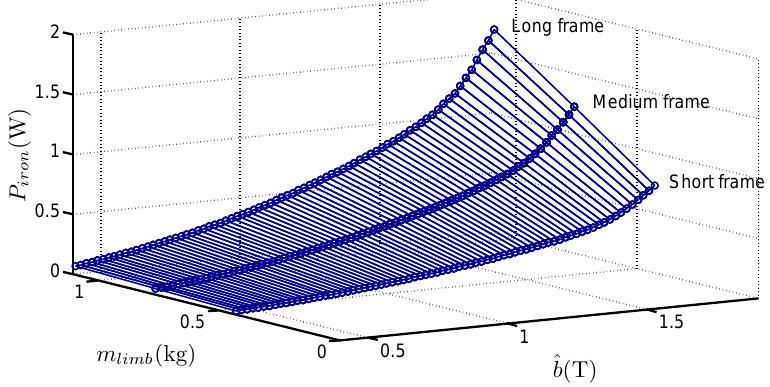
Figure 6. Variations of P iron with the mass increase of the limbs for G1 grade.